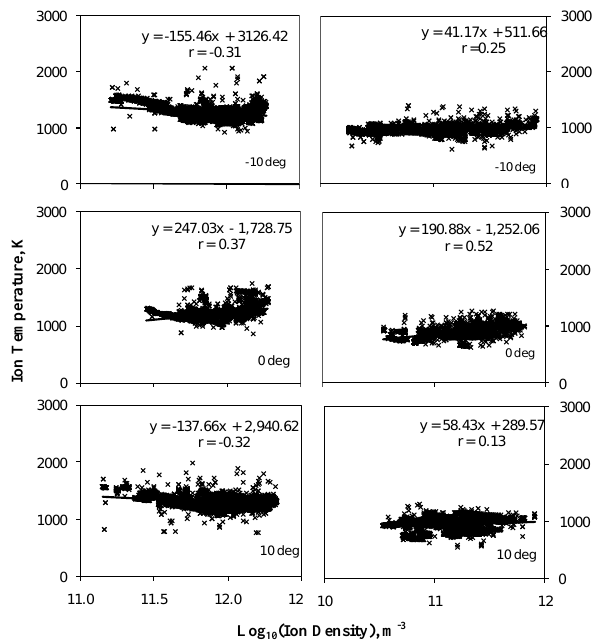
Fig. 5. Variation of daytime (left panel) and nighttime (right panel) ion temperature with corresponding ion density at − 10 ◦ , 0 ◦ and 10 ◦ magnetic latitude in the Indian zone during high solar activity (2000 and